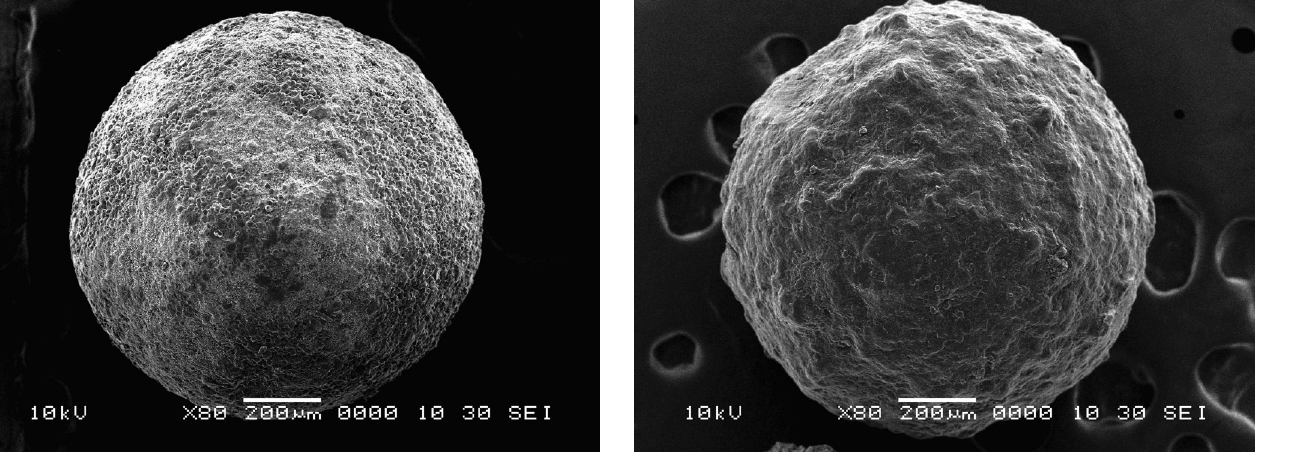
FIGURE 4 - Scanning electron microscopy of non pareil seeds (X80).